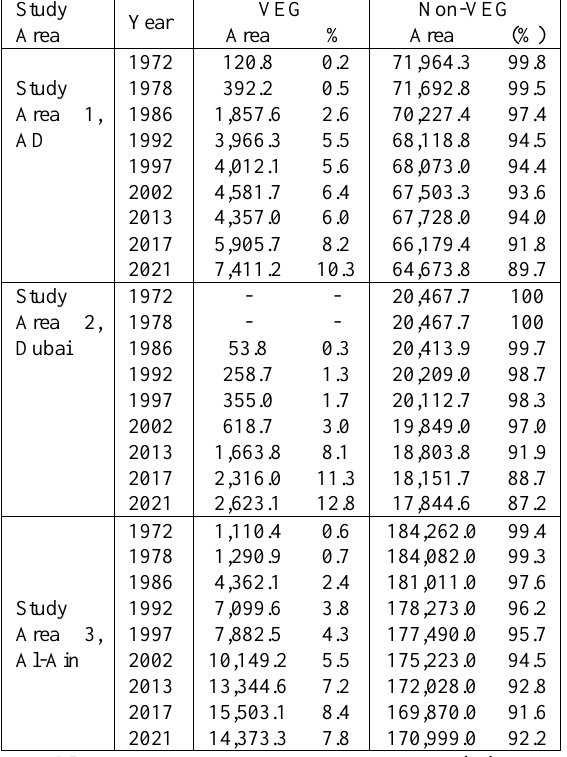
Table 12 . VEG and Non-VEG areas in hectare (ha) and percentages of the study areas during five decades.